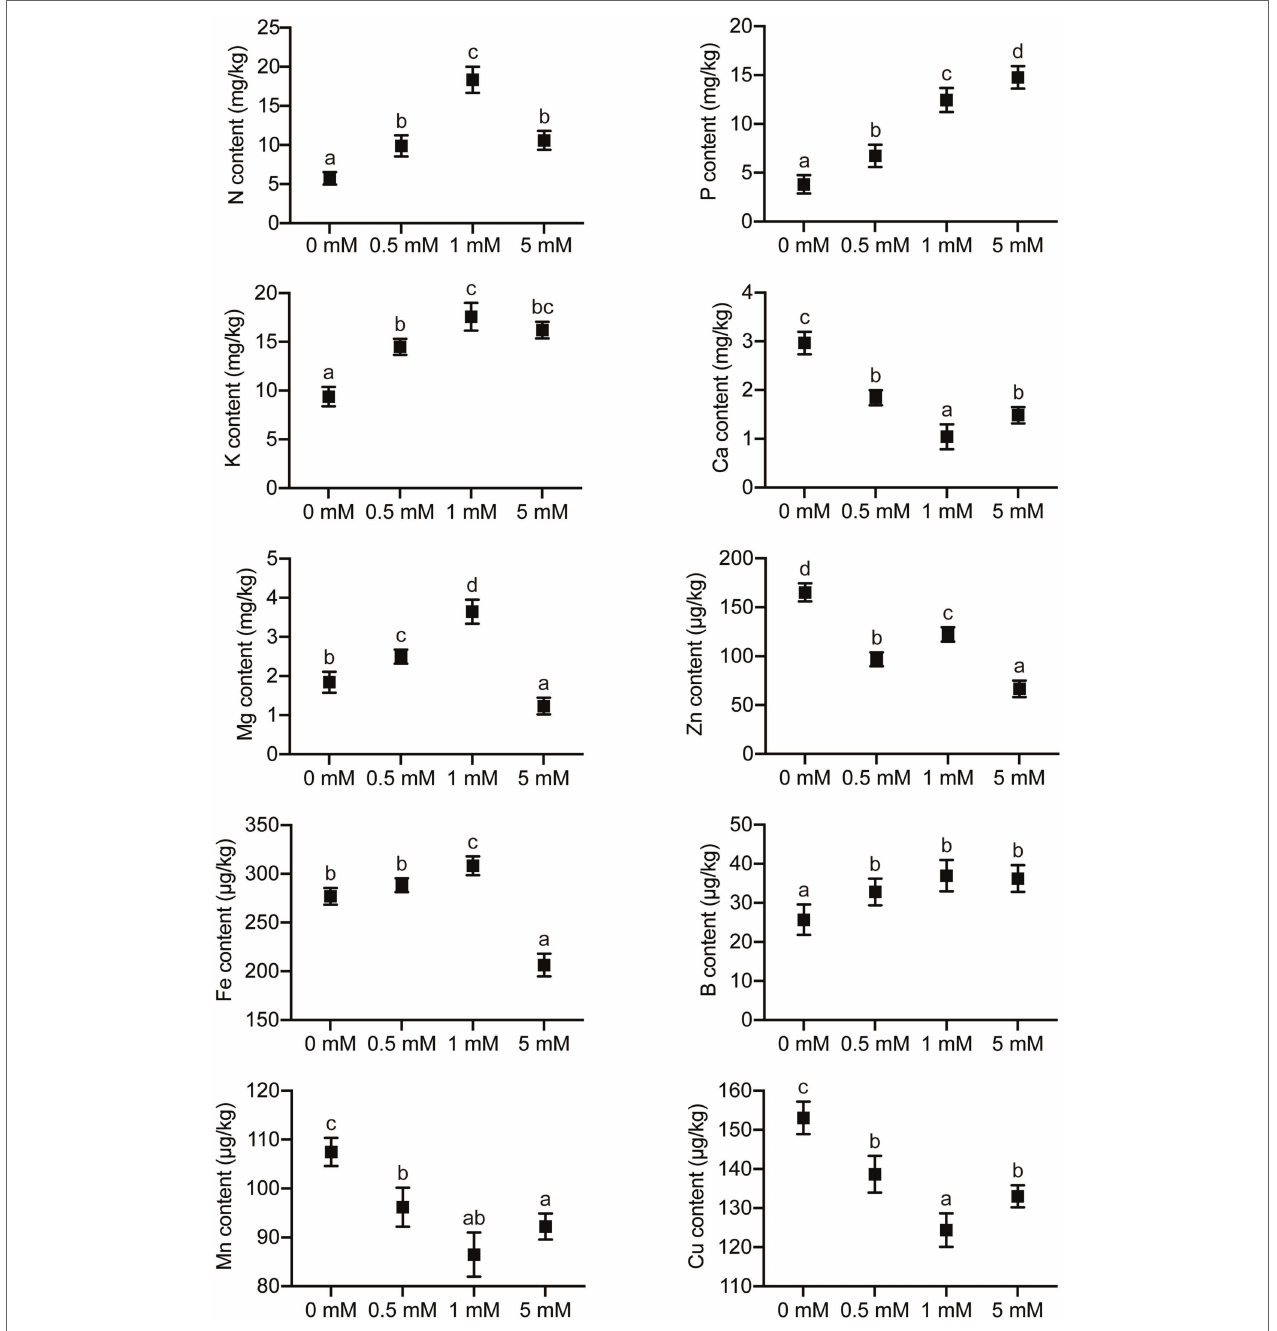
FIGURE 7 | The effects of P treatments on the concentrations of elements in pear seedlings. Response of concentrations of elements in pear seedling roots to P supply concentration. Data are presented as mean ± standard deviation of three replicates, and each replicate is based on measurements made from three plants. Samples in a bar chart with a common superscript letter are not significantly different ( p > 0.05), according to the Duncan’s multiple range